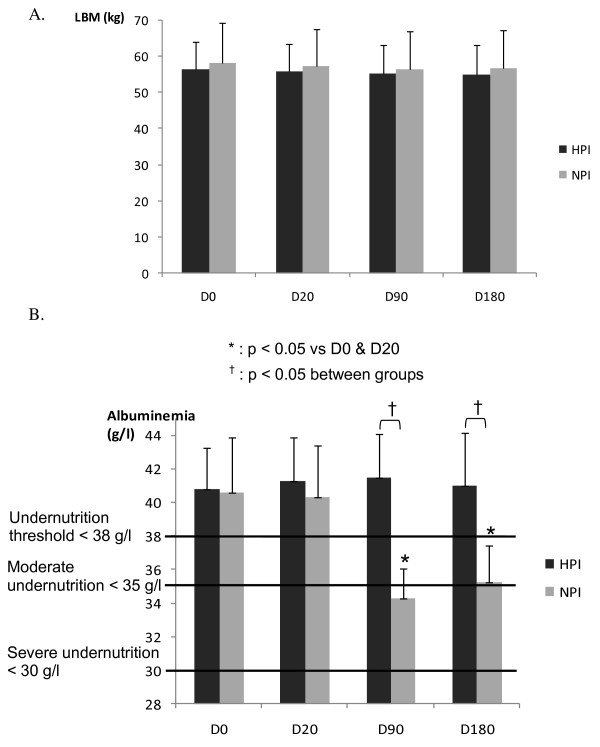
Change from baseline (day 0) to Month 6 (day 180) in albumin levels and lean body mass (LBM) for both groups: normal protein intake (NPI) set at 1.0 g/kg/d and high protein intake (HPI) at 1.2 g/kg/d. Solid bars represent albumin levels or lean mass in High protein intake group. Open bars represent albumin levels or lean mass in Normal protein intake group. T bars indicate standard errors. Panels A and B show the change in lean mass and albumin levels, respectively, for all participants (n= 28), who were randomly assigned to a High protein intake (n= 14) or to a Normal protein intake (n= 14). No missing data.